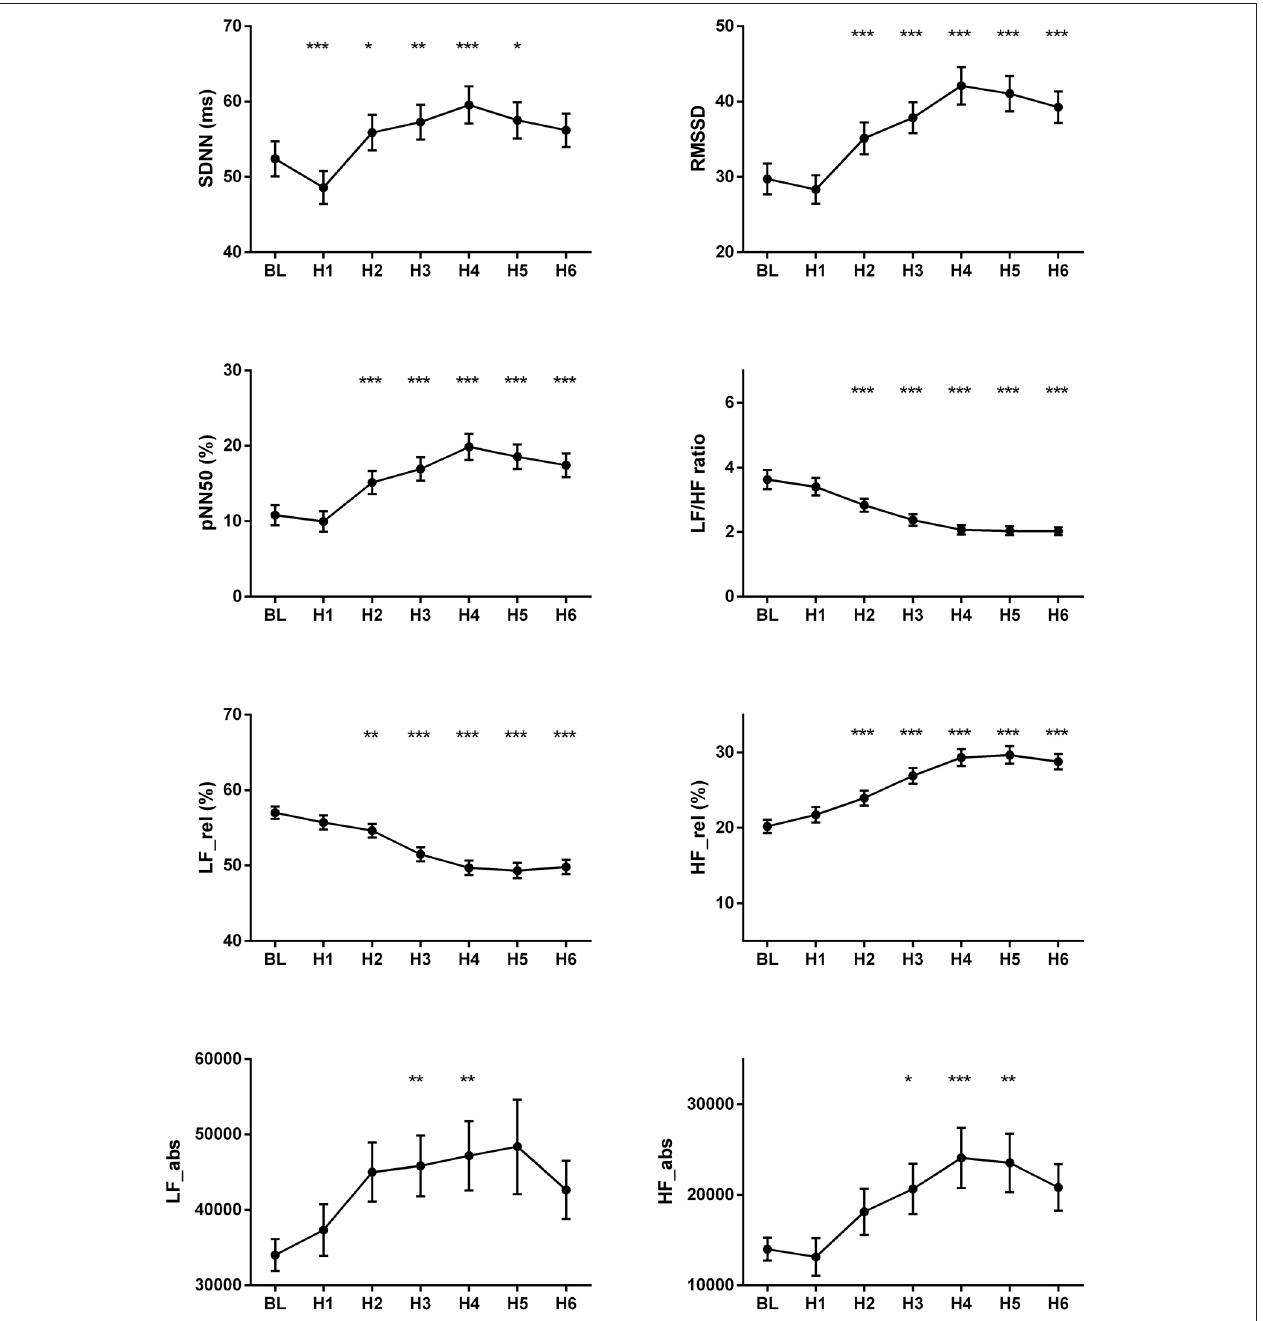
FIGURE 2 | Changes of the cardiovascular parameters after fingolimod administration. BL, baseline; H1, H2, H3, H4, H5, H6, the first, second, third, fourth, fifth, and sixth hour after fingolimod intake; HF_abs, absolute value of high frequency power; HF_rel, relative value of high frequency power; LF_abs, absolute value of low frequency power; LF_rel, relative value of low frequency power; pNN50, percentage of successive normal RR intervals differing by > 50 ms; RMSSD, the root mean square of successive differences of RR-intervals; SDNN, the standard deviation of normal RR intervals. Values are presented as mean ± SEM. * p < 0.05 compared with baseline, ** p < 0.01 compared with baseline, *** p < 0.001 compared with baseline.